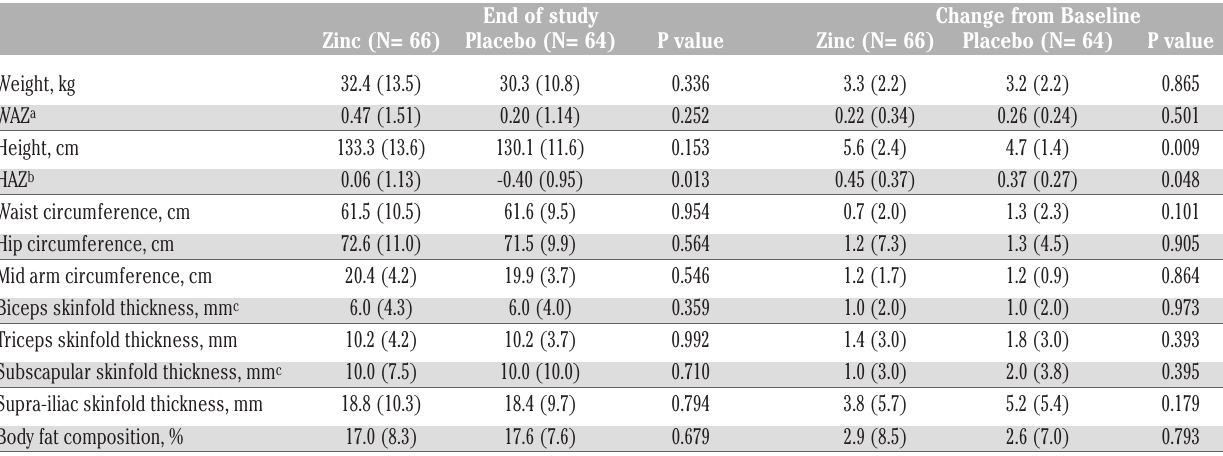
Table 2. Anthropometric data at the end of study and changes of anthropometric from at the beginning of study in the study groups. End of